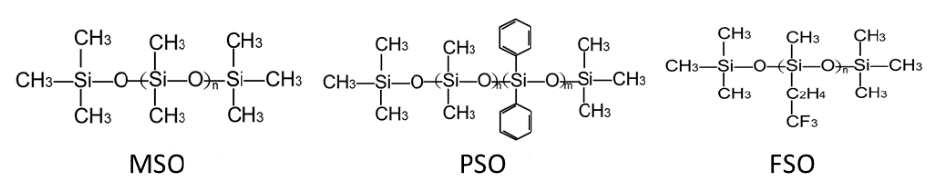
Figure 1. The structural formula of three types of inert silicone oils.